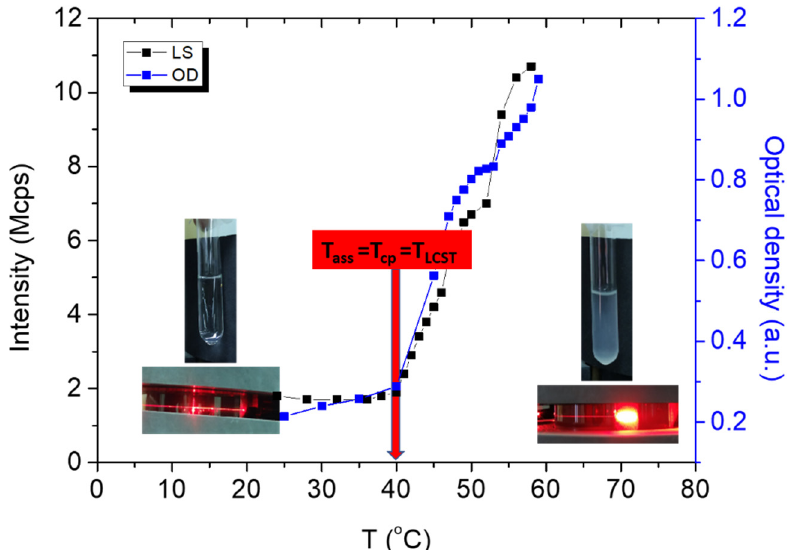
Figure 1. Example of temperature dependence of static light scattering intensity (LS) and optical density (OD) of the PLL-gNIPAM60 upon heating. The insets show digital photographs of the solution and the light scattering generated from a red laser, below and above the critical temperature. The cloud point T cp (detected by OD) coincides with the onset of the polymer association T ass (detected by LC).